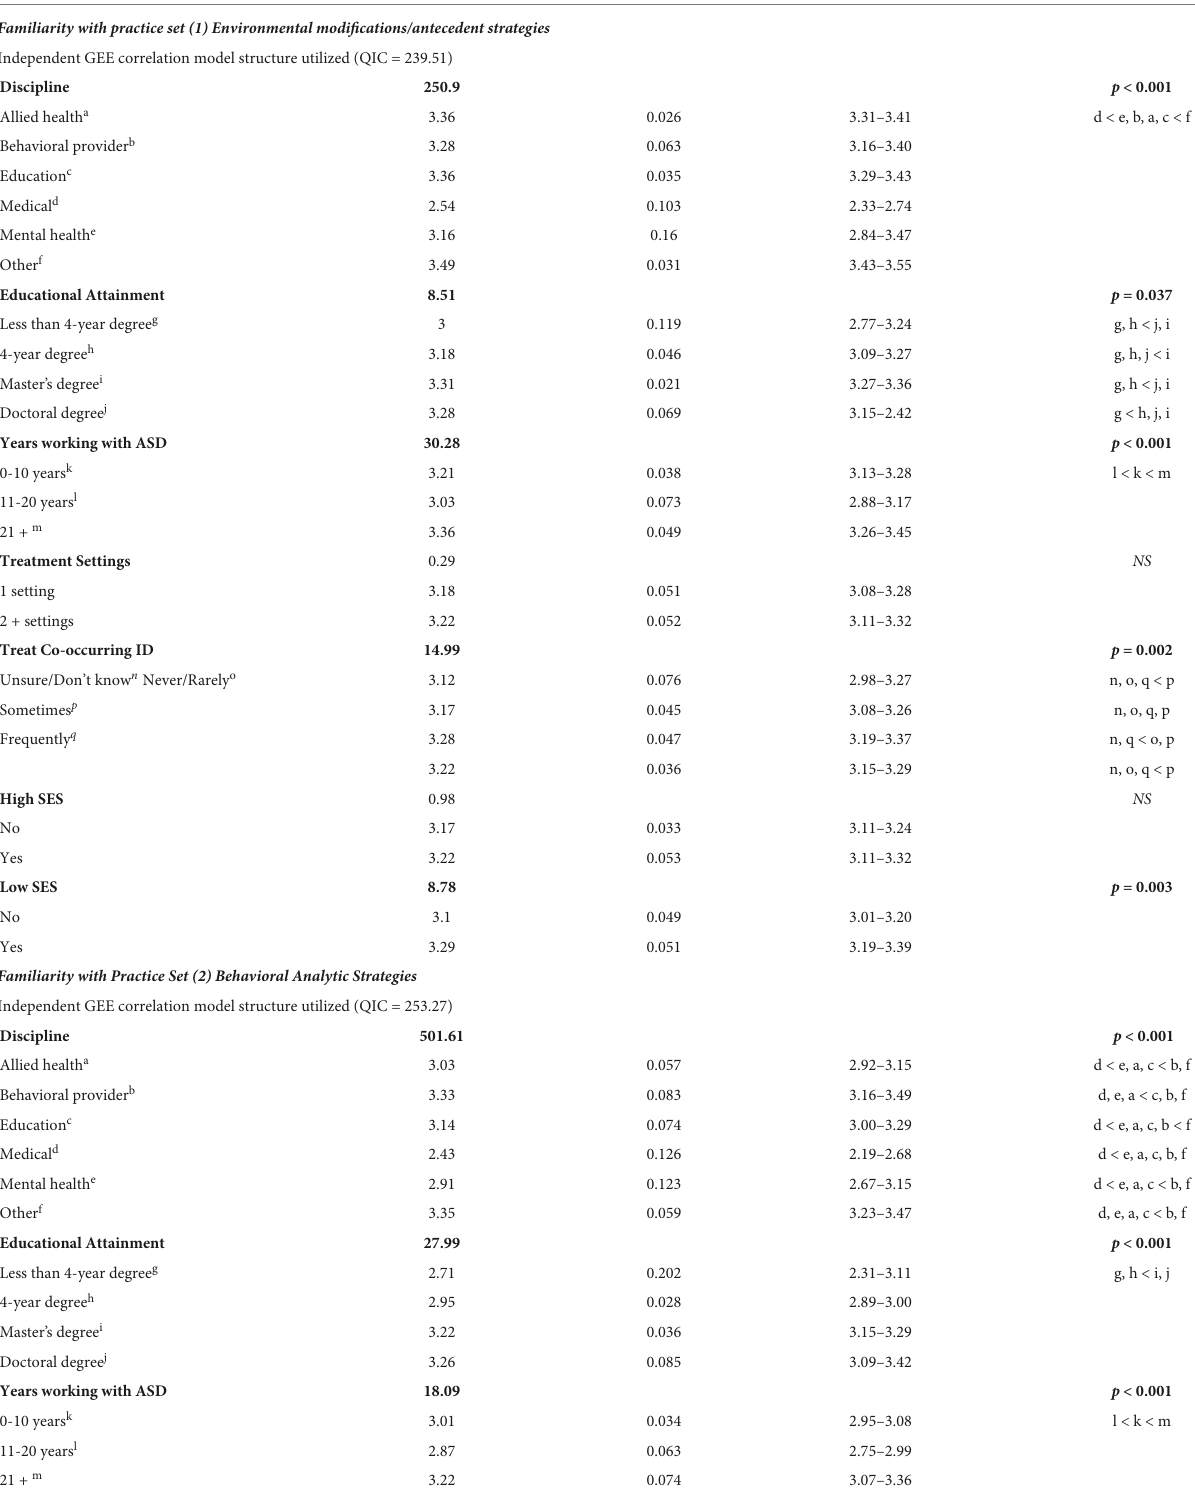
TABLE 3 Reported familiarity with practice